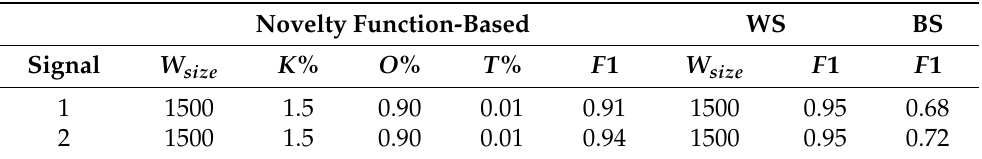
Table A2. Parameter configuration and experimental results of each signal in Dataset 1 (HAR, see Section 3.1). W size : window size; K %: kernel size in percentage of the window size; O %: overlap percentage of the window size. T %: amplitude threshold for event detection; WS: window-based segmentation; BS: binary segmentation. The tolerance used to calculate the F1-score ( F 1) equals the window size for novelty function computation.